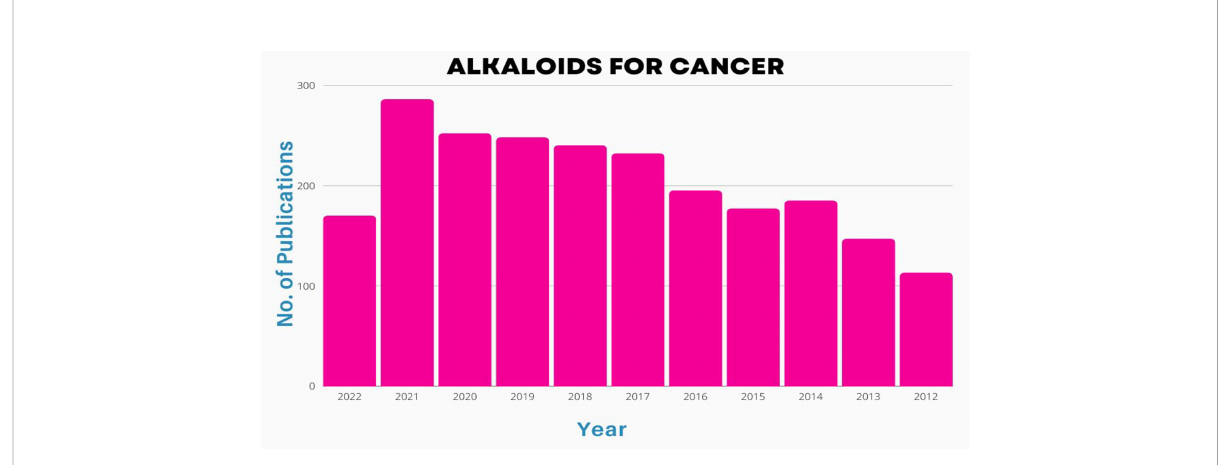
FIGURE 3 Number of publications [2002-2022] on basis of alkaloid application in treatment of